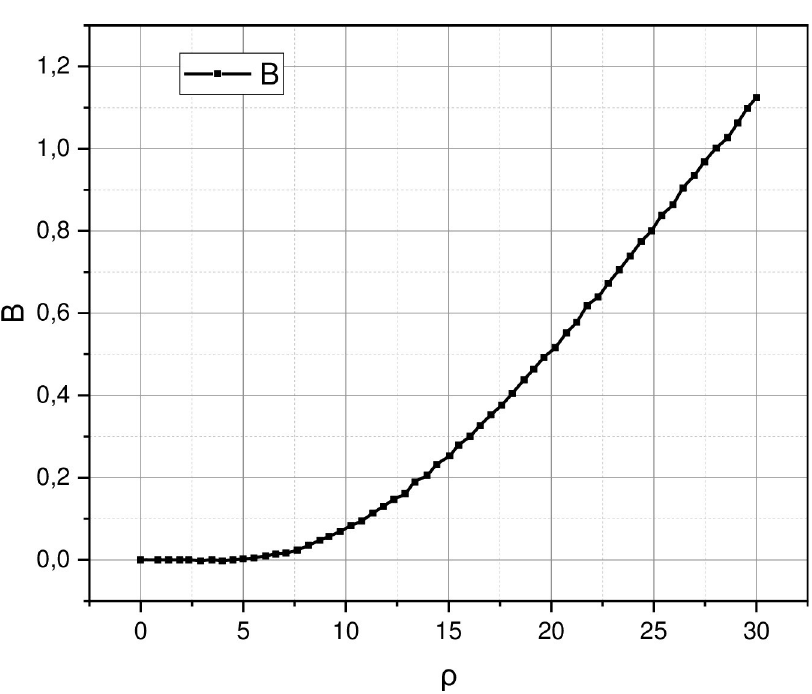
Fig 3. Functional dependencies B = f ( ρ ) calculated based on model (17) for the obtained experimental data.